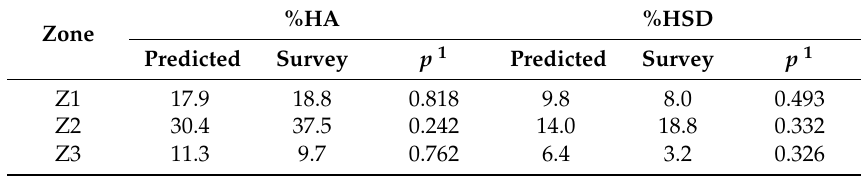
Table 5. Comparison between predicted and survey %HA and %HSD in three residential zones. %HA %HSD Zone Predicted Survey p 1 Predicted Survey p 1